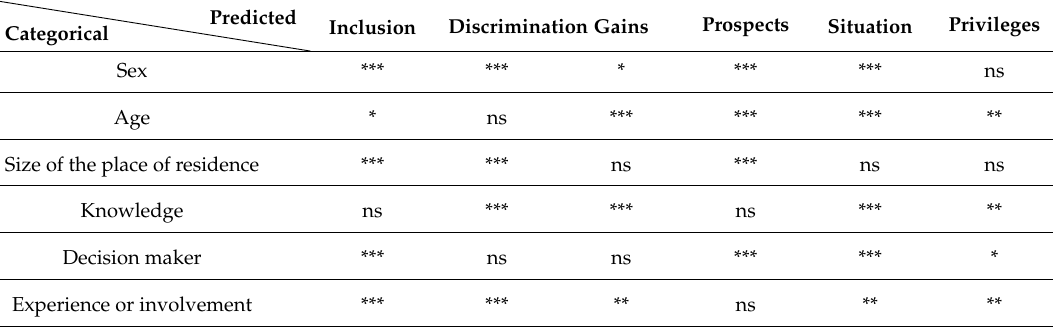
Table 4. Significance of predictors in multi-way ANOVA main e ff ects only model (F test).